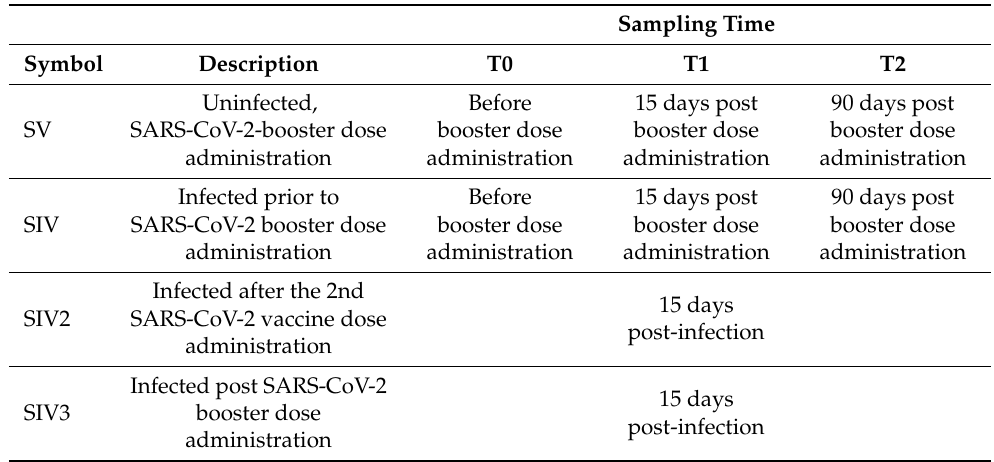
Table 2. Meaning of the acronyms of the enrolled groups and the sampling